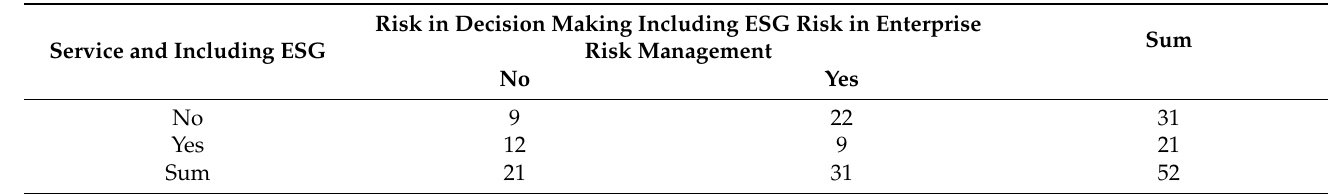
Table 16. Cross-way table for variables: Service and Including ESG Risk in Enterprise Risk Manage- ment (0.271).